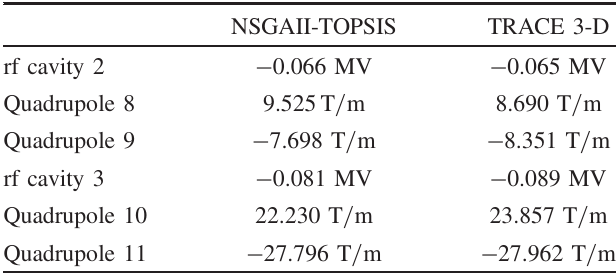
TABLE III. Comparison of solutions from TRACE 3-D and from the joined NSGAII and TOPSIS method. Shown are the values of six transverse and longitudinal MEBT knobs, optimized by either program, for matching the 10 mA RFQ output beam to the DTL. The knob numbers are indicated in Fig.